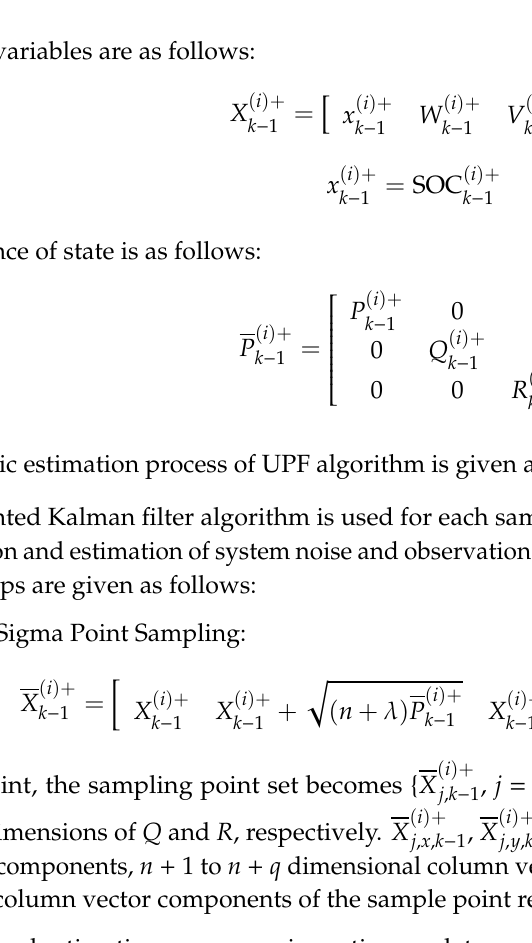
Figure 8. Principle of UPF (unscented Kalman particle filter) state estimation.